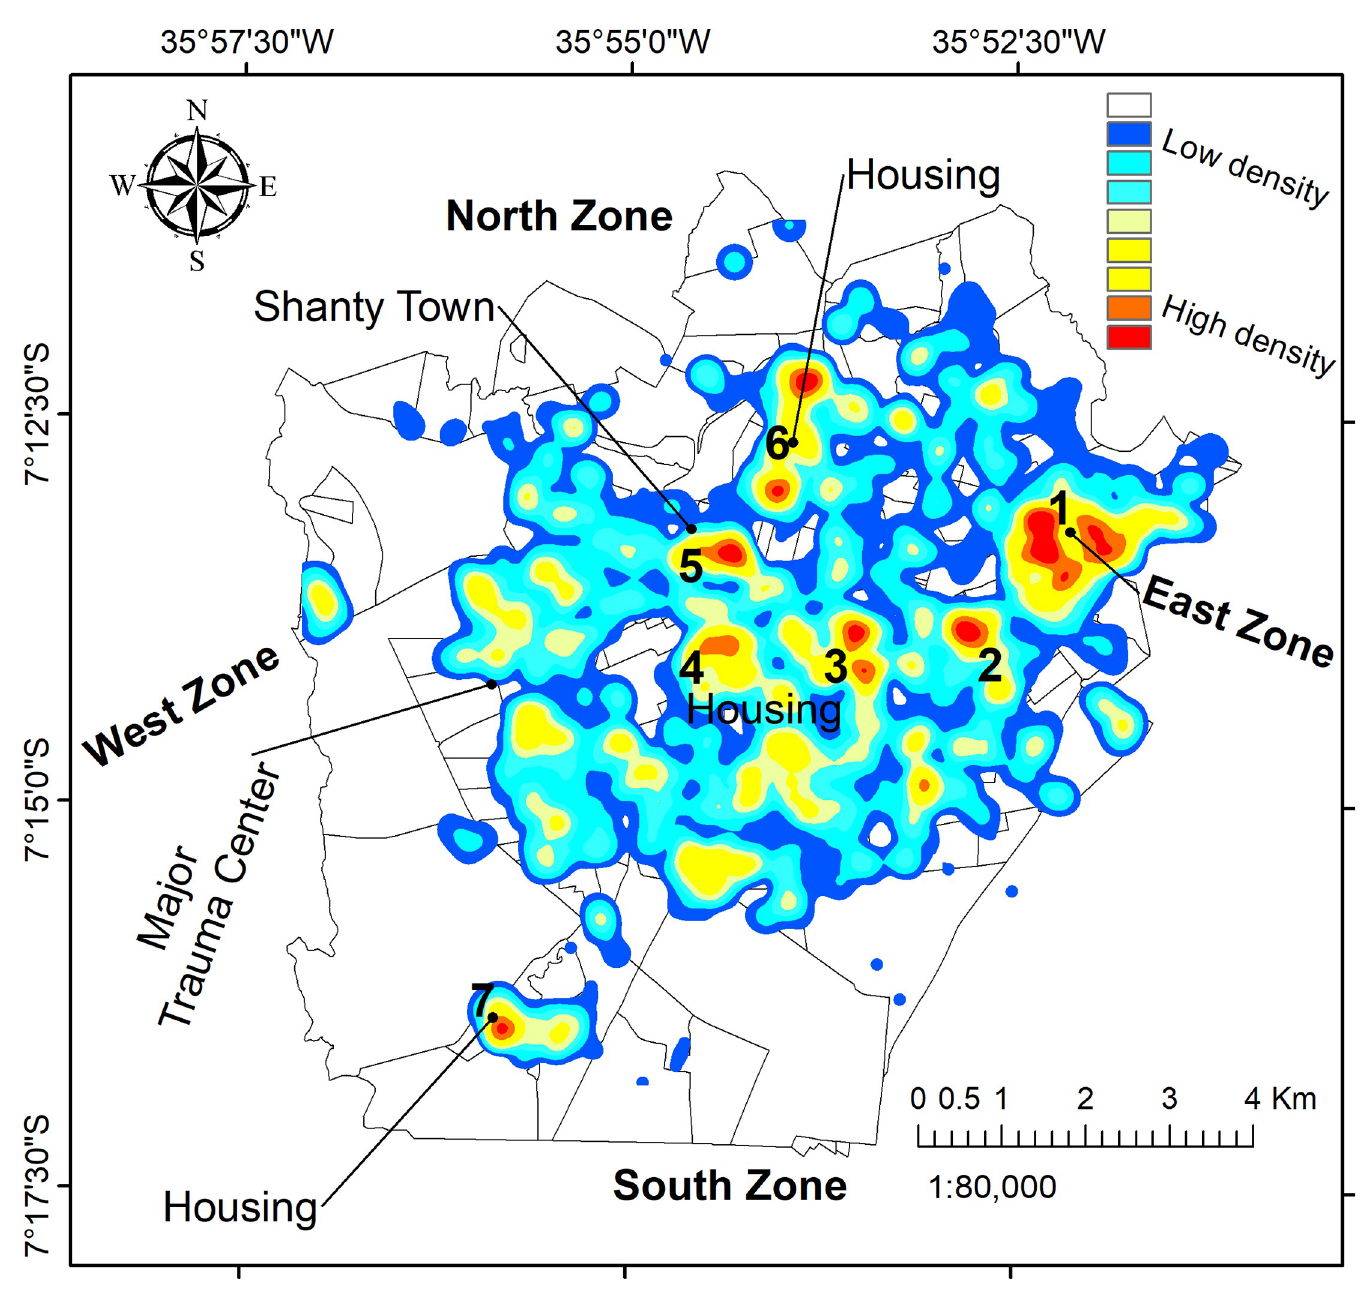
Fig 3. Density of all physical violence cases by victim’s household address. The seven most prominent clusters are numbered.